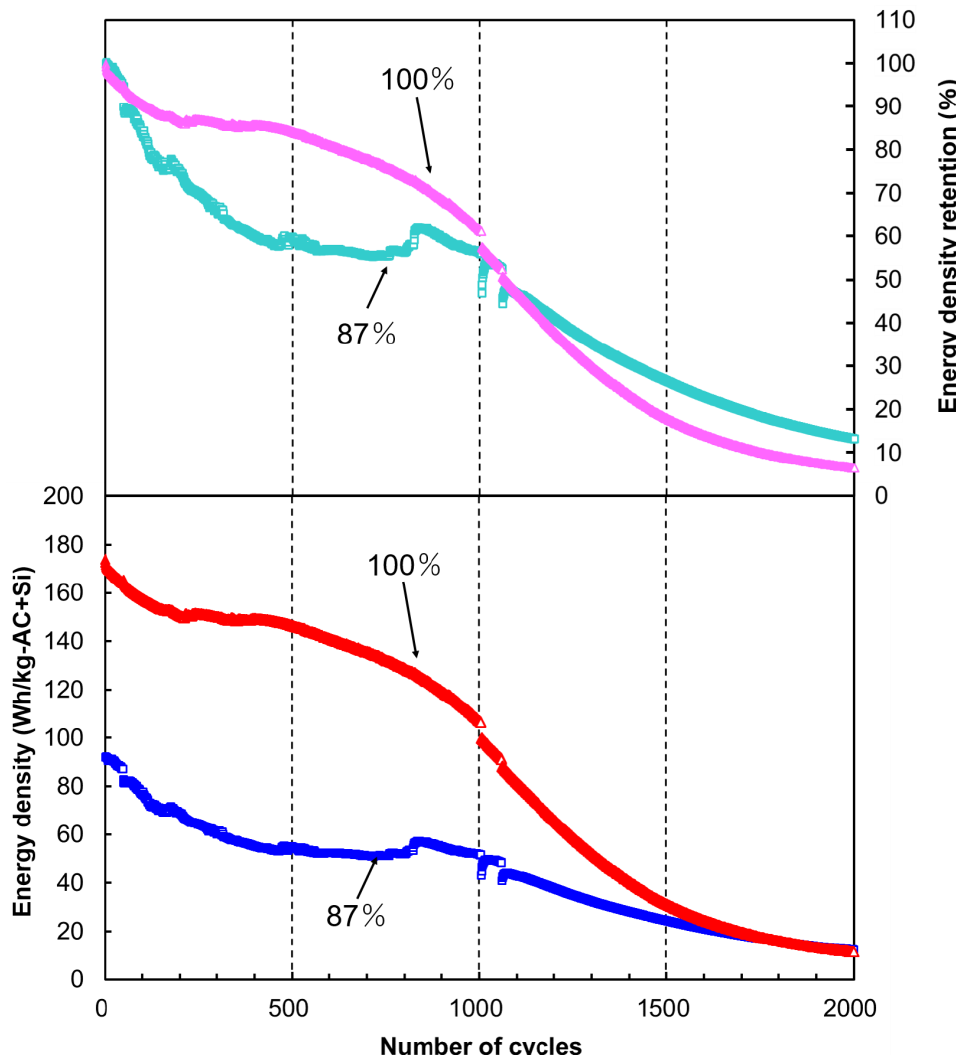
Figure 6. Energy densities and energy density retention of the 100% and 87% prelithiation cells during the cycle test at a constant current density of 1.0 mA/cm 2 .